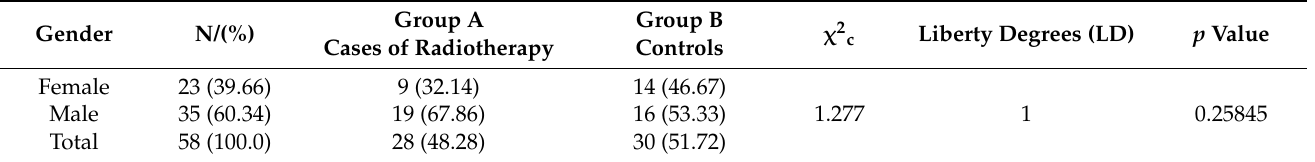
Table 1. The gender structure of the study